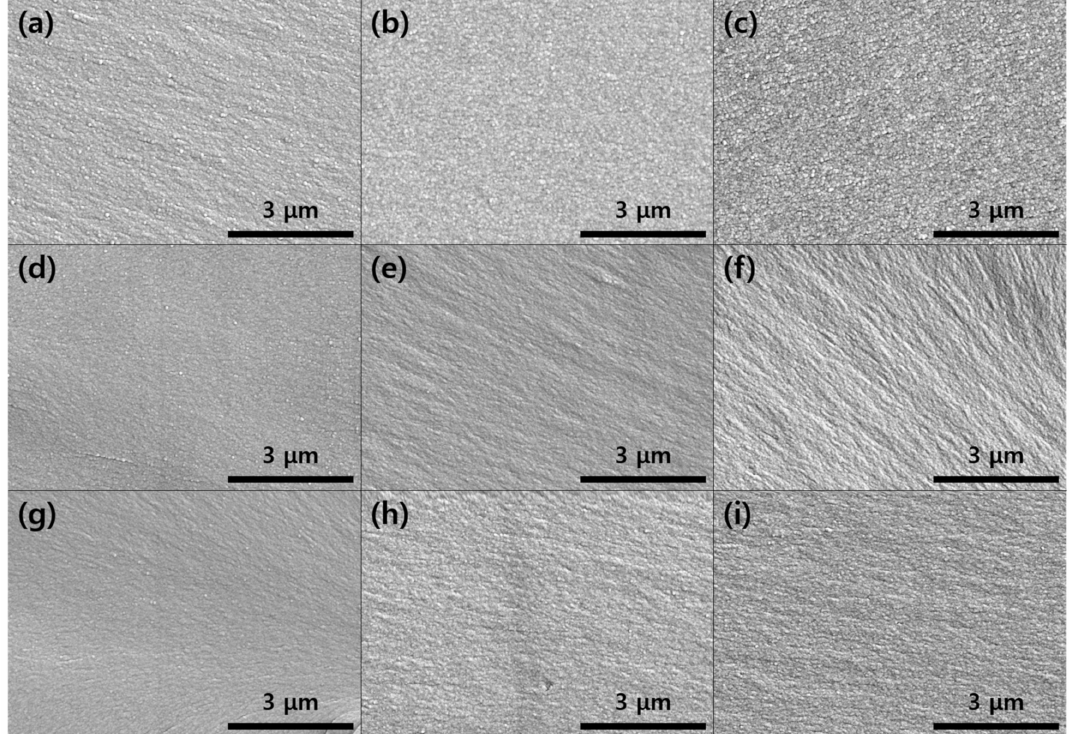
Figure 6. SEM images of the fracture surfaces of the prepared epoxy samples: ( a ) DGEBA; ( b ) DGEBF; ( c ) TGAP; ( d ) DGEBA/PTK; ( e ) DGEBF/PTK; ( f ) TGAP/PTK; ( g ) DGEBA/PTS; ( h ) DGEBF/PTS and ( i )